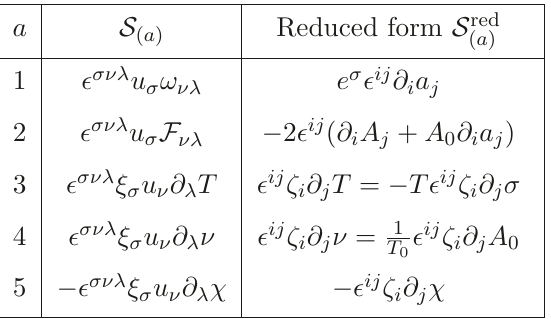
Table 1 . Parity-odd first order scalars in 2 + 1 dimensions and their dimensional reduction.